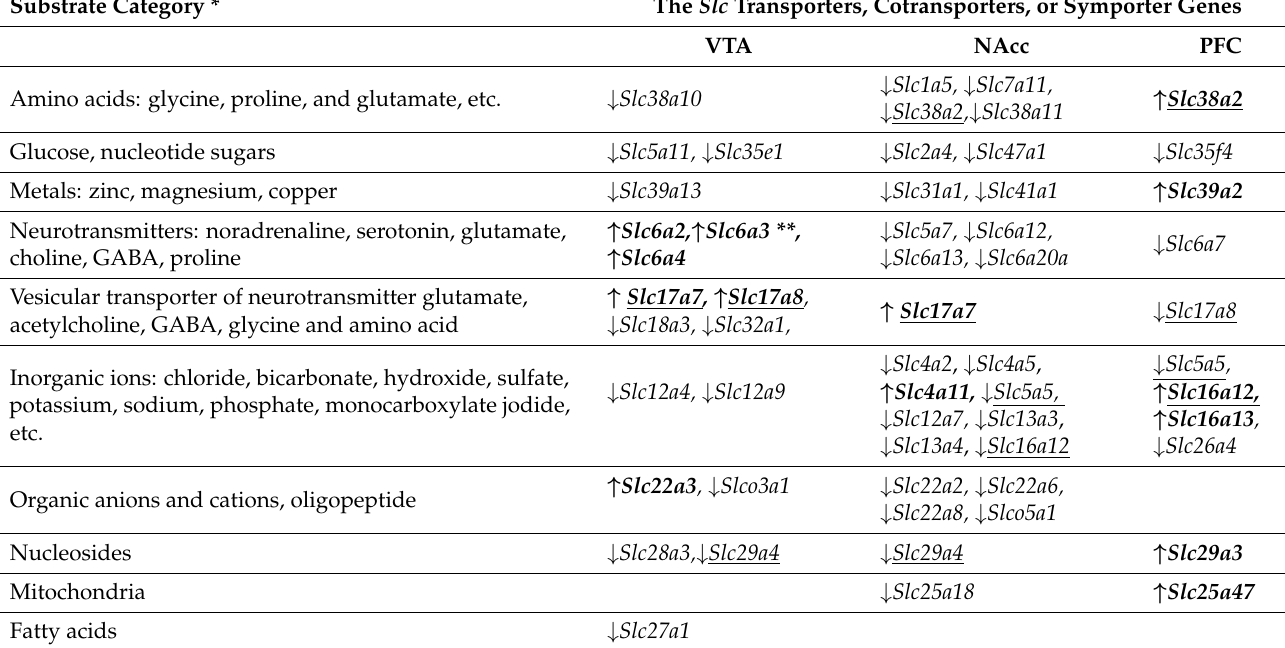
Table 1. Slc DEGs encoding the transporters in different brain regions according to type of substrate category for every gene. Substrate Category